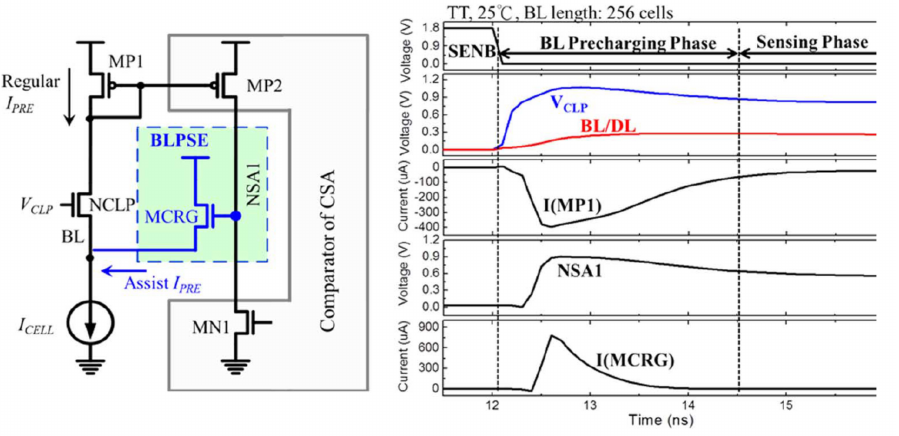
Figure 22. The structure and simulation of BLPSE [76]. Figure 23a shows that the variation in voltage of BL is reduced by 45% and 56% compared with the conventional scheme and PTFA without